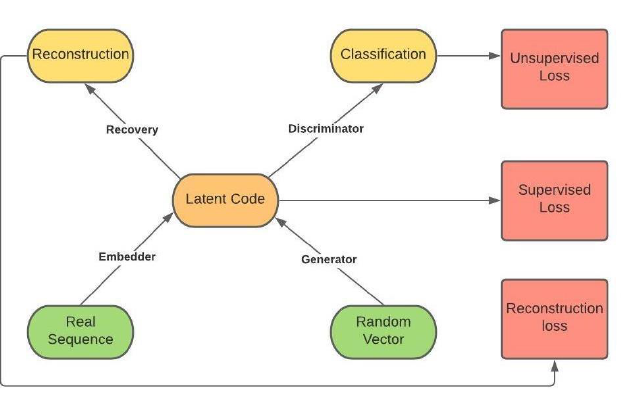
Figure 2. Time variant GAN Framework